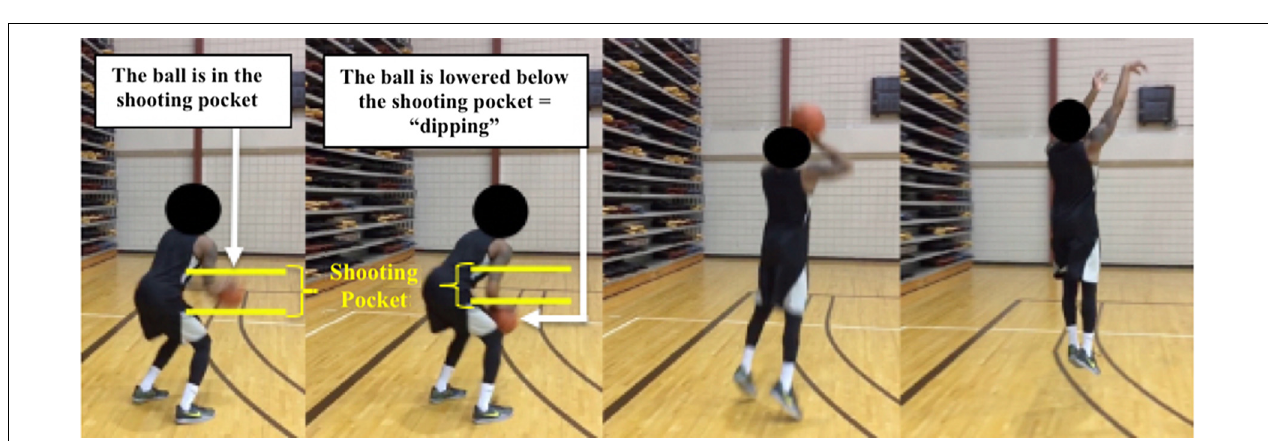
FIGURE 2 | Schematic diagram of the experimental set-up showing the positions of the shooter (3.125, 4.925, 6.025, and 6.750 m), the side view camera (at each of the shooting positions), the front view (7.05 m from the sideline), and the passer (7.05 m from the sideline); front view camera and passer alternate depending on handedness of shooter.